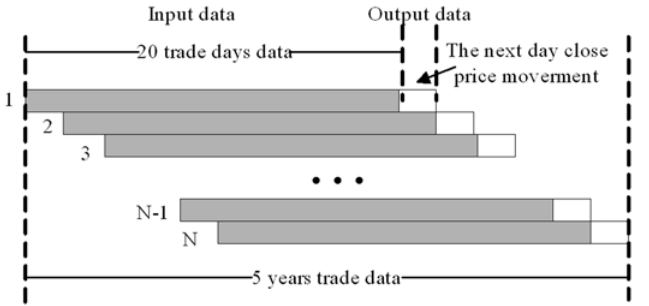
Fig 3. Diagram of building up the dataset. Stock time series segmentation is made by 20 width sliding window. The gray block represents the input data which including 20 trading day ’ s data. The white block represents the target output data which is the next day's closing